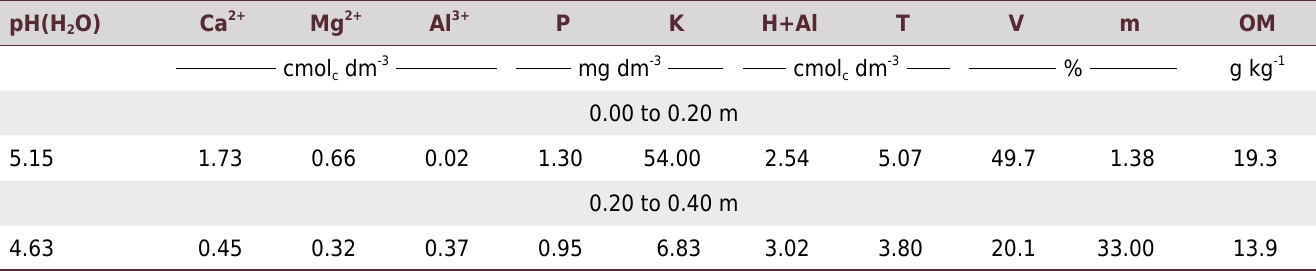
Table 1. Soil chemical characterization at the 0.00 to 0.20 and 0.20 to 0.40 m soil